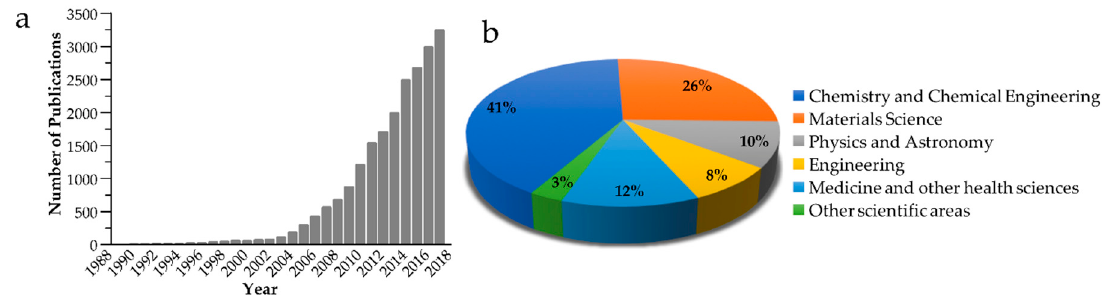
Figure 2. ( a ) Number of publications per year and ( b ) publications by subject featuring stimuli-responsive gel. Databased used for the bibliographic analysis: Scopus ® Elsevier, Amsterdam, The Netherlands consulted on the 2nd of May 2018.